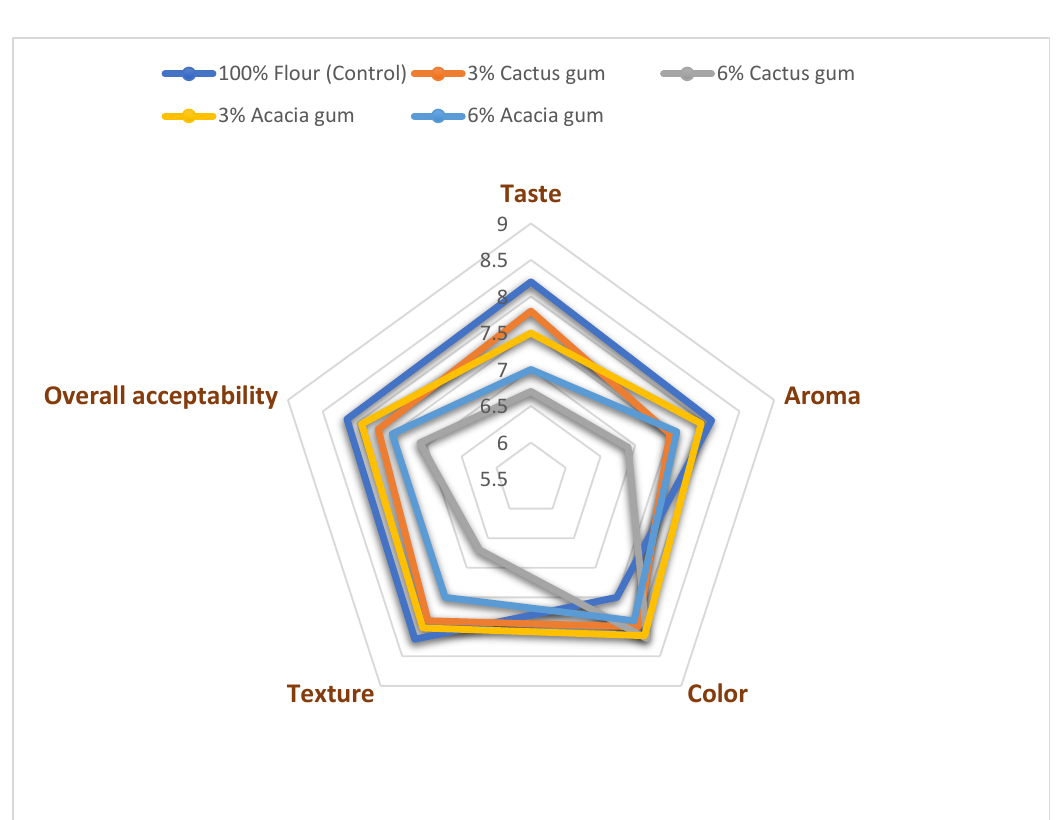
Figure 4. Sensory scores assigned to cookies.